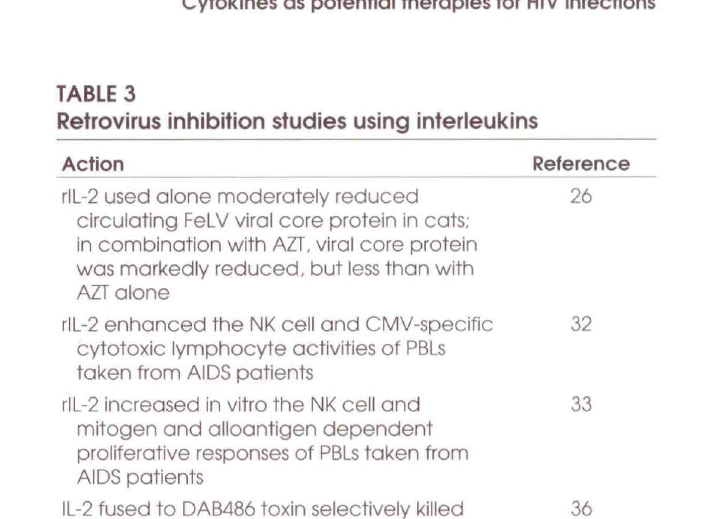
Retrovirus inhibition studies using interleukins